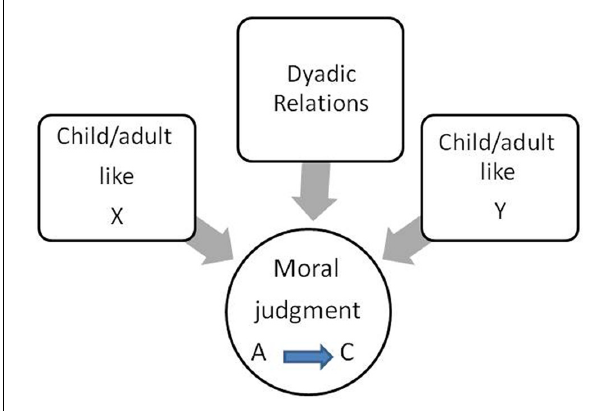
FIGURE 2 |The attachment model of moral judgment. In generating a non-conscious moral judgment, we perform two mental operations: we impose a dyadic structure of child–adult/agent–patient (Gray etal., 2012) on two parties in conflict and we compare the behavior of A toward C with our prior expectations of what adults should and should not do to children. Acts that violated our expectations are judged as morally wrong.Whilst the decision as to which party is C or A is highly subjective, the general traits that are associated with children and those associated with adults are constant and universal.